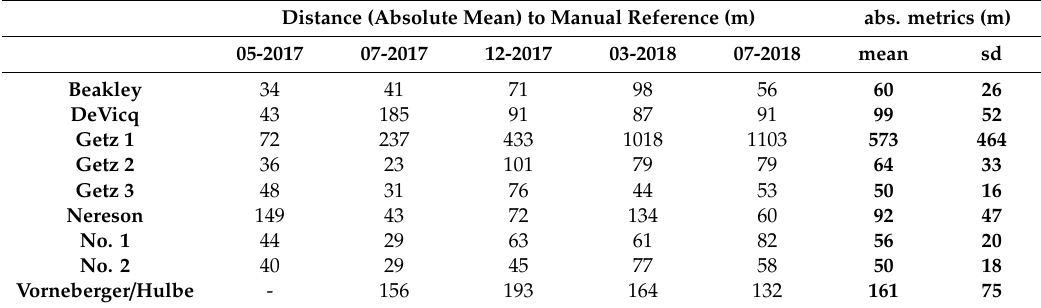
Table 3. Error calculation for the Getz time series with five manual reference coastlines. The distance to the reference coastlines is presented as the absolute mean of the measured transect values.